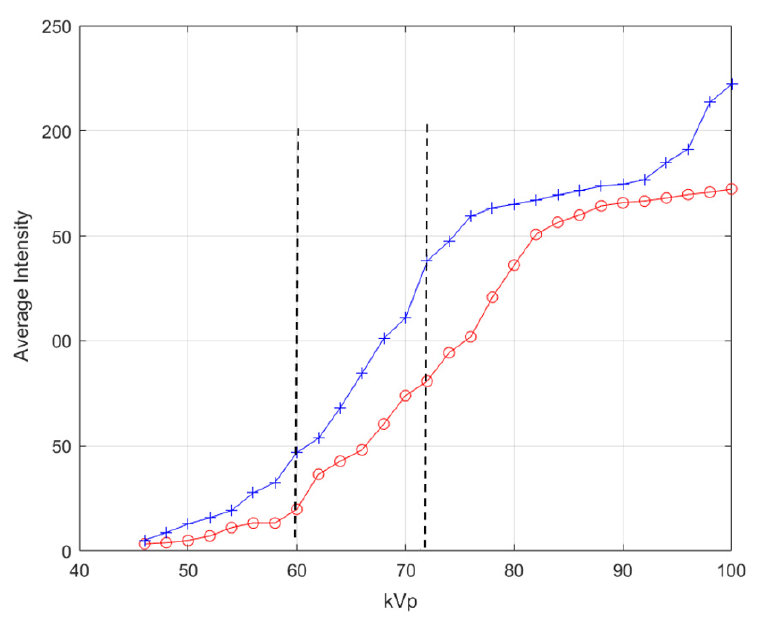
Figure 8. Linearity test of indirect X-ray detector; Between dash line shows the linear response. (red: 25 mA, blue: 50 mA).